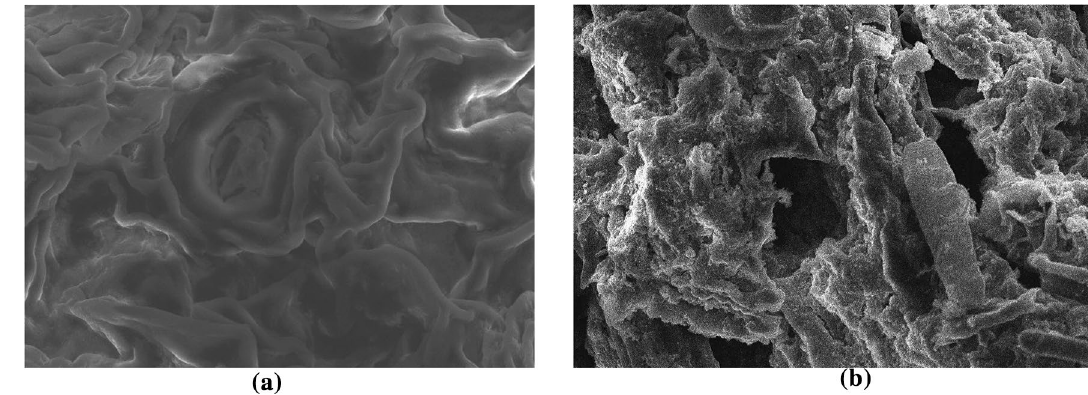
Fig. 16 a SEM images of waste tea leaves before treatment, b SEM images of waste tea leaves after